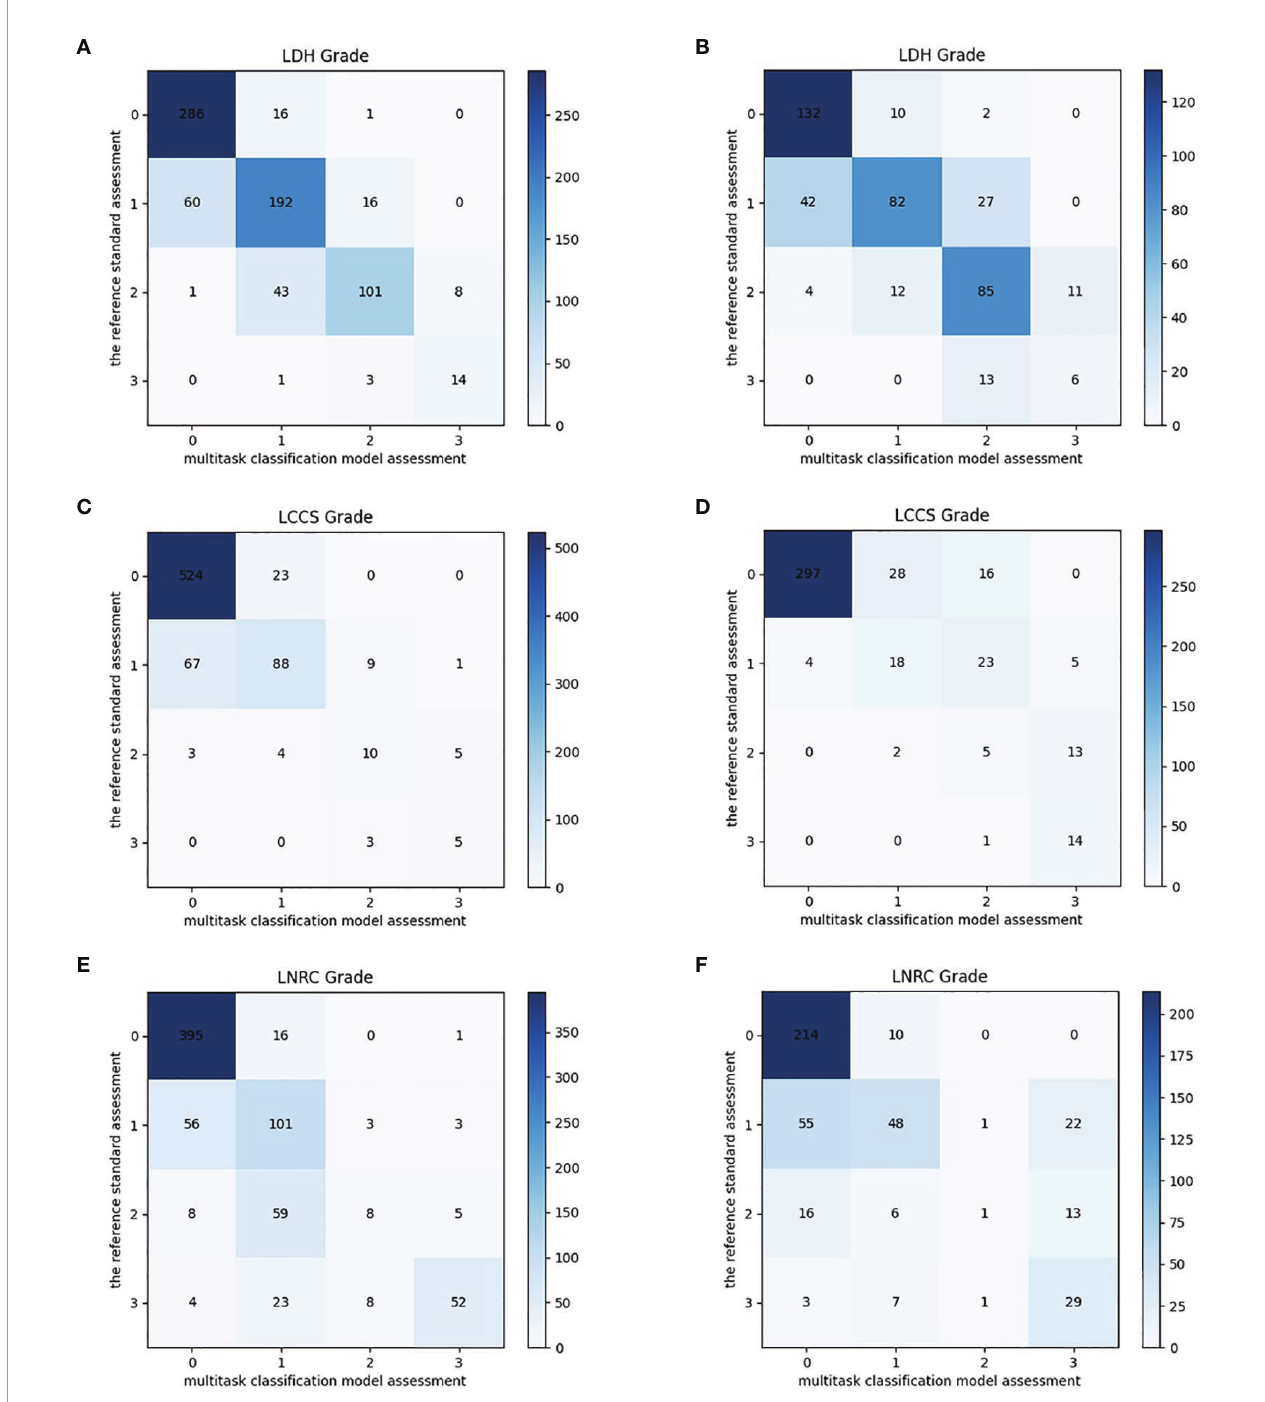
FIGURE 7 | Confusion matrix of the multi-task classi fi cation model at lumbar MRI levels. Confusion matrix of the multi-task classi fi cation model for grading lumbar disc herniation LDH (A) , lumbar central canal stenosis LCCS (C) and lumbar nerve roots compression LNRC (E) on the internal test dataset. Confusion matrix of the multi-task classi fi cation model for grading LDH (B) , LCCS (D) and LNRC (F) on the external test